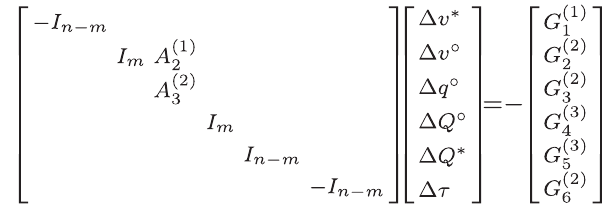
Figure 8. Reduced Jacobian